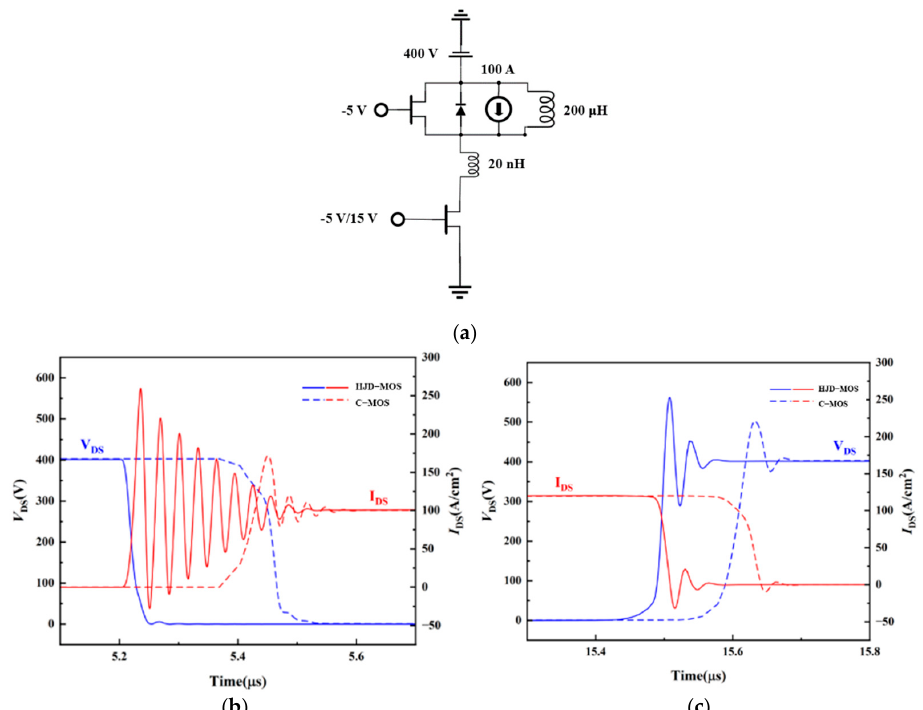
Figure 10. ( a ) Double pulse test circuits. ( b ) Turn-on and ( c ) turn-off waveform of the C-MOS and the proposed structure.